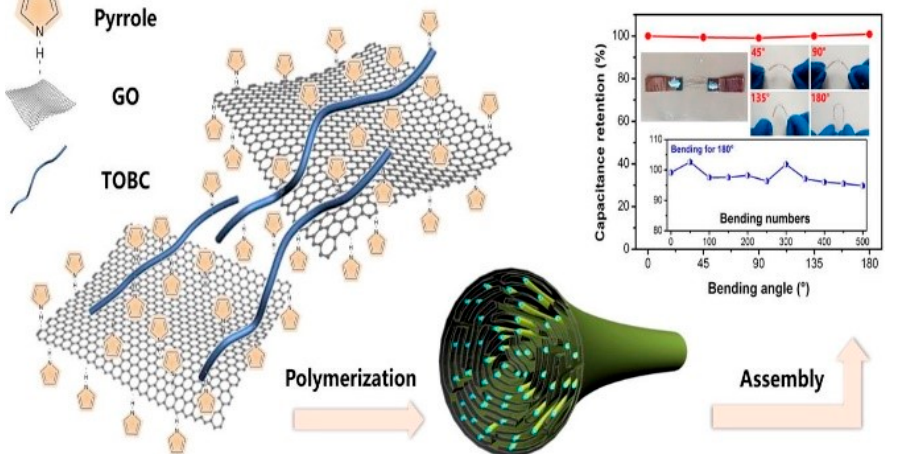
Figure 18. Flexible supercapacitor based on the polypyrrole@TEMPO-oxidized bacterial cellulose– reduced graphene oxide (PPy@TOBC–rGO) macrofibers. Reprinted with permission from [219]. Copyright 2019 Elsevier.